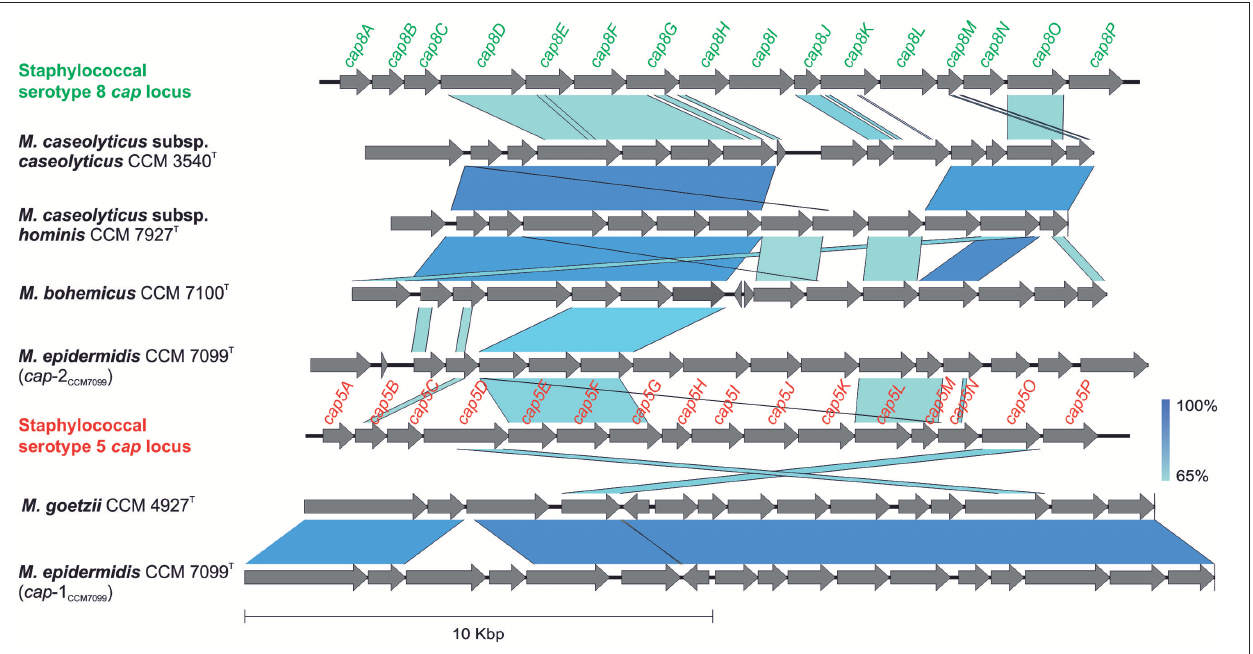
FIGURE 5 | Comparison of genetic structure of putative capsule ( cap ) gene clusters in sequenced genomes of human macrococci with staphylococcal cap5 (GenBank accession number U81973) and cap8 (GenBank accession number U73374)